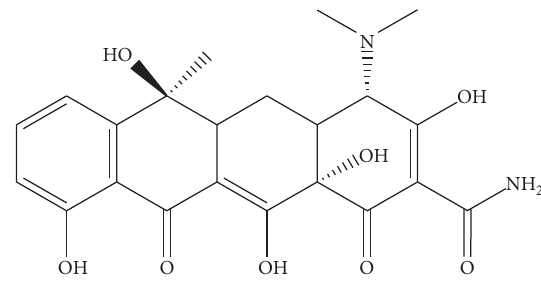
Figure 1: Molecular structure of